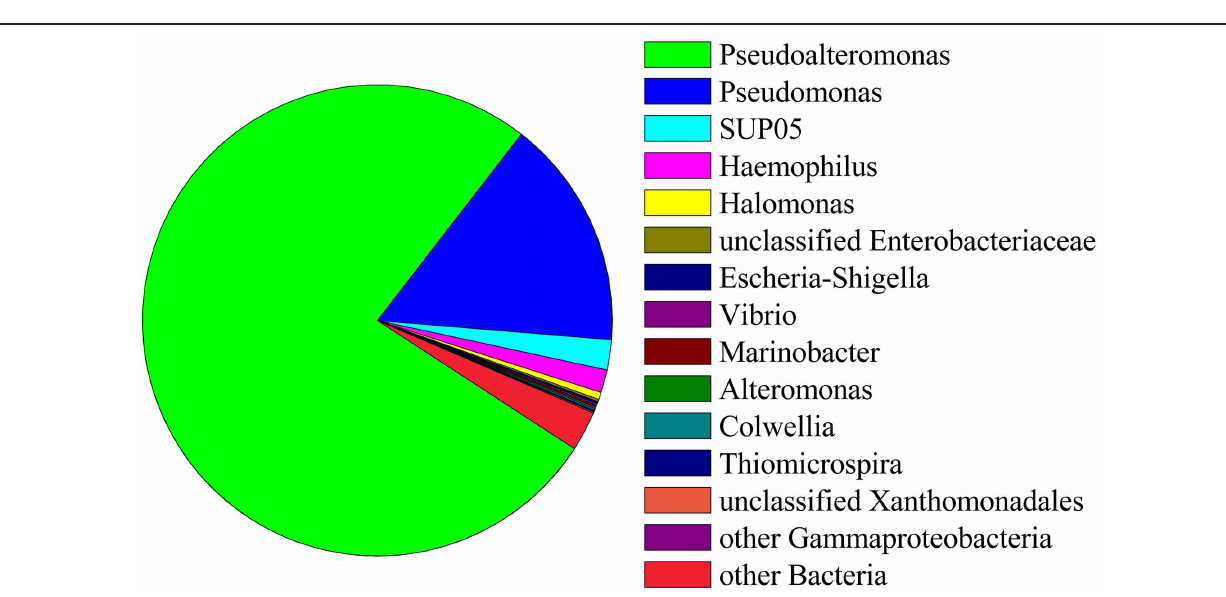
both fluid samples and in white floc 2 and made up more than 9% of reads in white floc 1. In contrast, less than 0.1% of reads in the orange floc were assigned to Bacteroidetes VC2.1 Bac22.